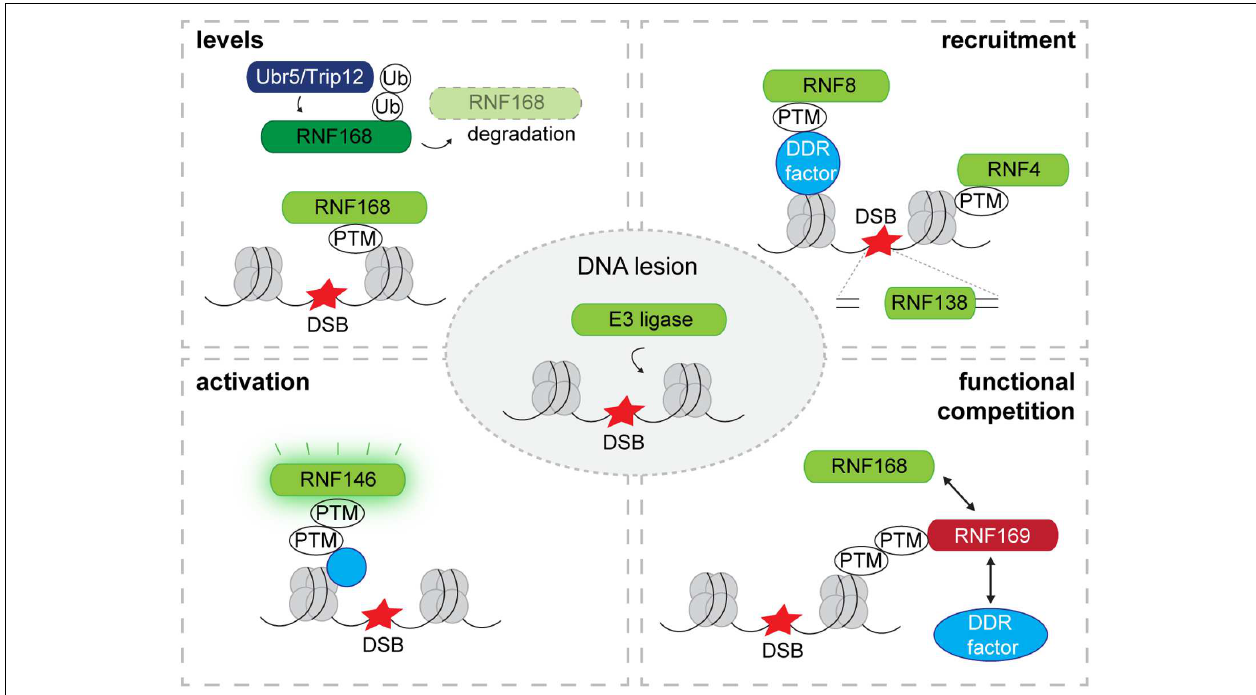
FIGURE 1 | Recruitment and regulation of E3 ligases at DNA lesions. Levels: E3 ligases are targeted by other E3 ubiquitin ligases for proteasomal degradation. Proteasomal degradation of E3 ligases limits the quantity of E3 ligases that translocate to DNA lesions as has been observed for RNF168 which is targeted for degradation by TRIP12 and UBR5. Recruitment: The recruitment of E3 ligases to DSBs is often mediated by PTMs that are attached to the chromatin or chromatin-associated proteins. Some E3 ligases are recruited by directly binding to free DNA ends exposed at DSBs. Activation: While most E3 ligases in complex with their E2 possess constitutive enzymatic activity, a PTM can activate E3 ligase activity as has been observed for the PAR-dependent ubiquitin ligase RNF146. Competition: Competitors negatively regulate the recruitment of E3 ligases by binding to PTMs that facilitate the binding of E3 ligases as has been observed for RNF168 and its competitor RNF169. DSB, DNA double-strand break; Ub, ubiquitin; PTM, post-translational modification; DDR, DNA damage